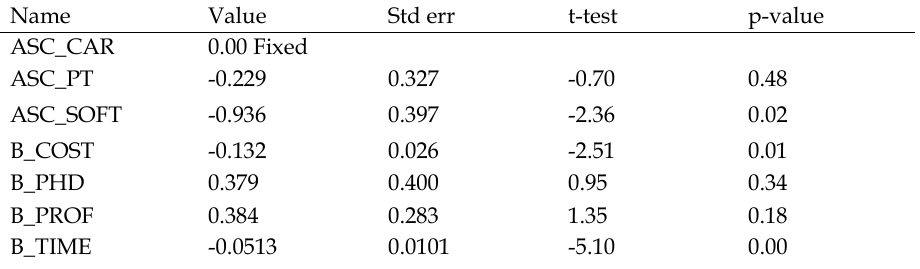
Table 1. Results of the MNL calibration